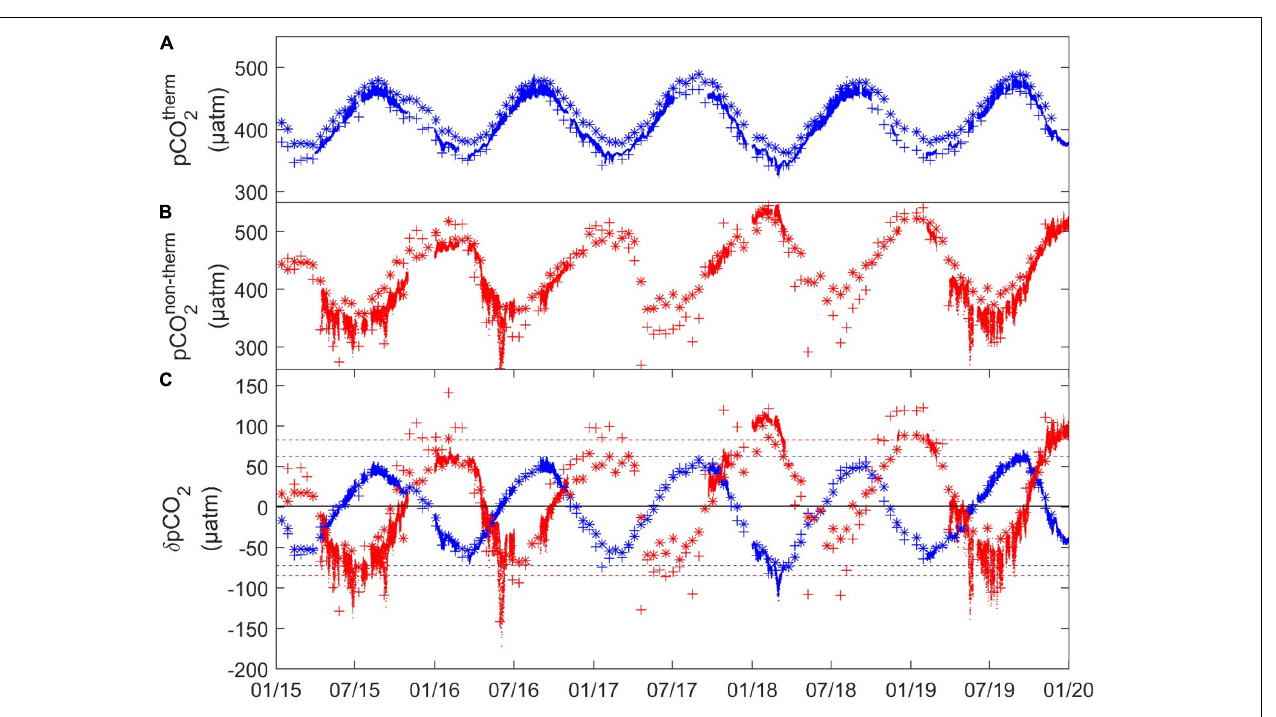
FIGURE 9 | (A) pCO 2 therm (blue), (B) pCO 2 non − therm (red) (C) δ pCO 2 therm = pCO 2 -pCO 2 non − therm (blue) and δ pCO 2 non − therm = pCO 2 -pCO 2 therm (red) (all in µ atm) for (.) High-frequency, (+) SOMLIT-pier, and (*) SOMLIT-offshore data. Dashed lines represent the maximum and minimum of the monthly mean of δ pCO 2 therm (blue) and δ pCO 2 non − therm